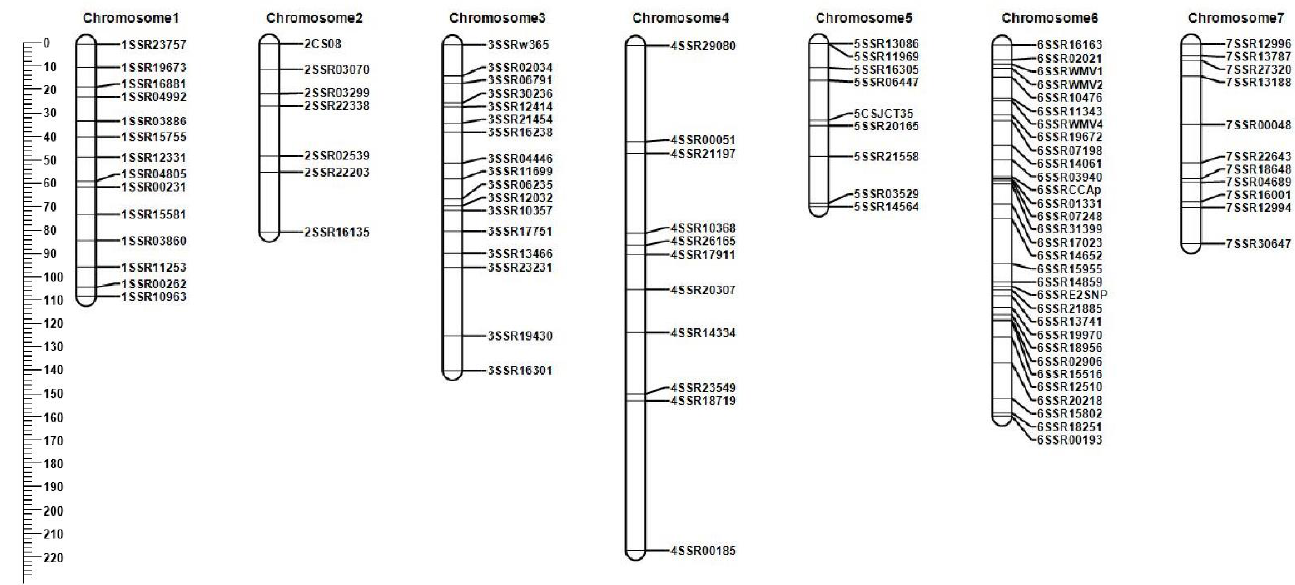
Figure 3. Linkage map of the recombinant inbred line (RIL) population. The tick mark represents the position marked on the chromosome.